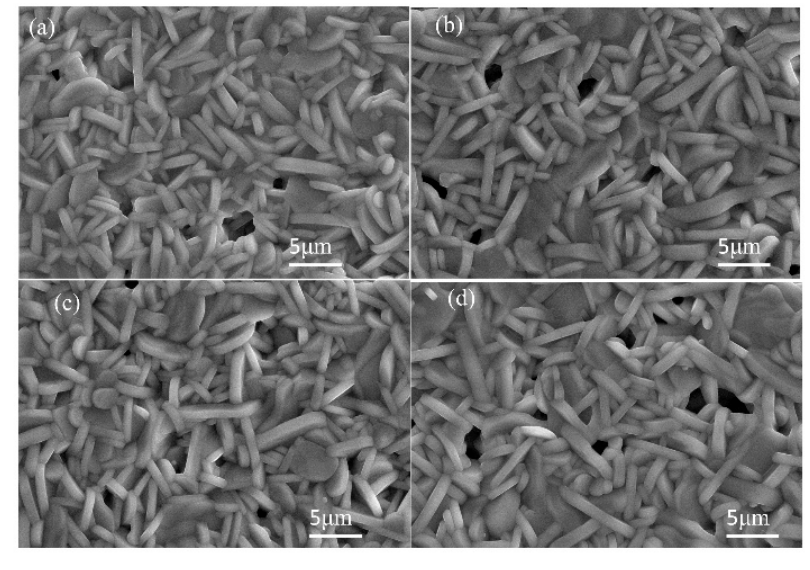
Figure 8. SEM images of LNT with various Ti content at 1373 K for 1 h under 0.35 MPa. ( a ) 15 mol %,